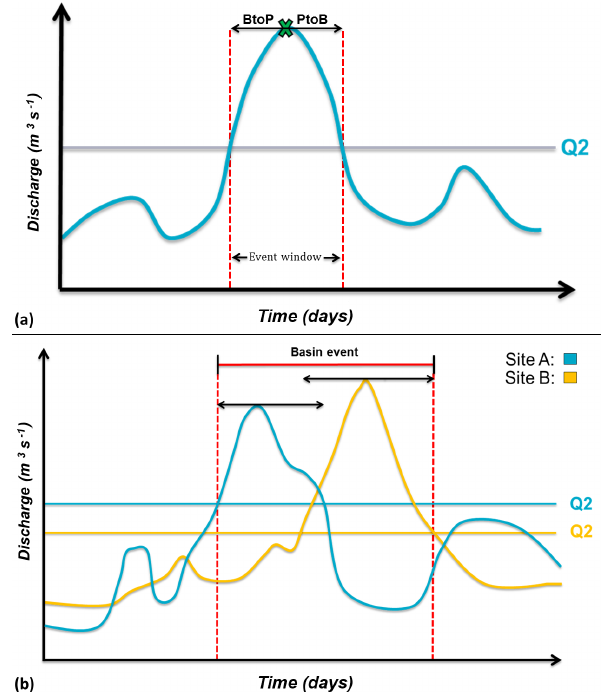
Figure 2. (a) Site event identification and (b) basin event identifi-